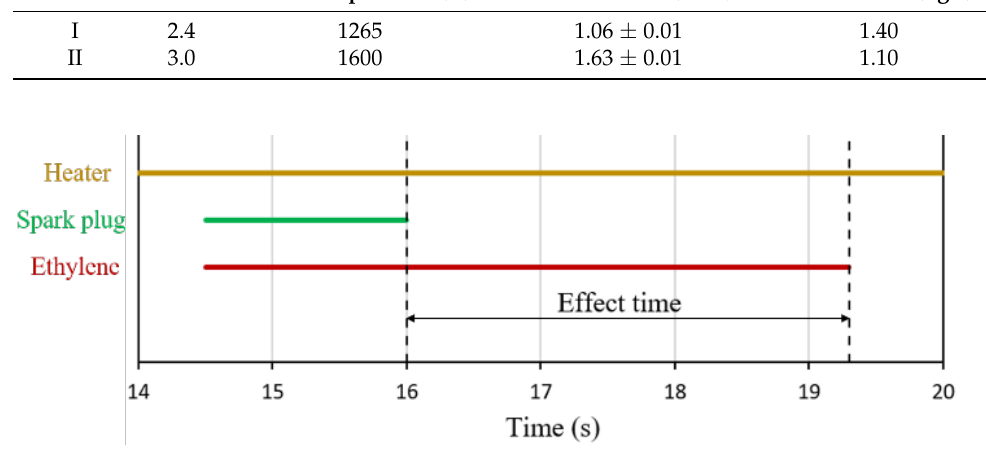
Table 1. The inflow conditions of test.